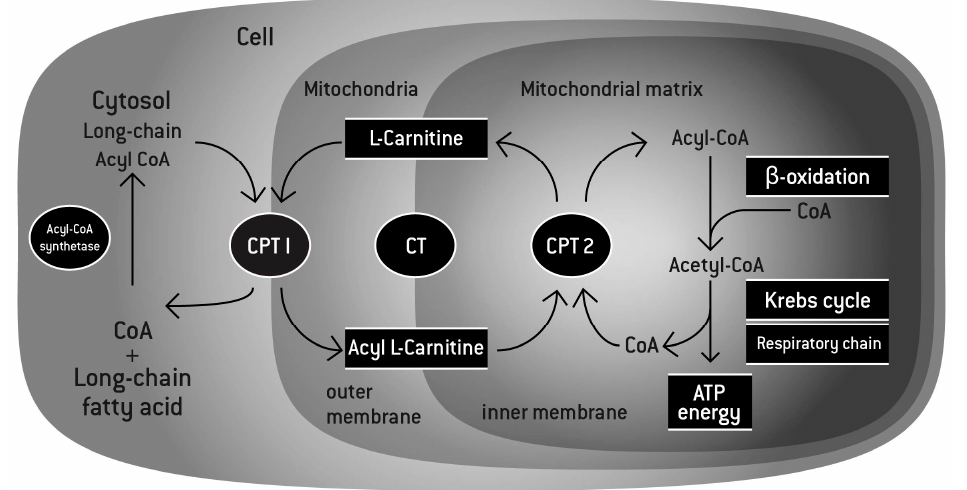
Figure 1. L -carnitine function. L -carnitine shuttles long-chain fatty acids inside the mitochondria by forming a long chain acetylcarnitine ester. The complex is then transported into the mitochondrial matrix by carnitine palmitoyltransferase I (CPT I) and carnitine palmitoyltransferase II (CPT II). The fatty acids are then broken down through the process of β -oxidation to deliver the 2-carbon molecules to the Krebs cycle, leading to the generation of energy under the form of adenosine triphosphate (ATP). In addition, by binding an acetyl group, L -carnitine can maintain the levels of Acetyl-CoA and coenzyme A, playing its buffering role.